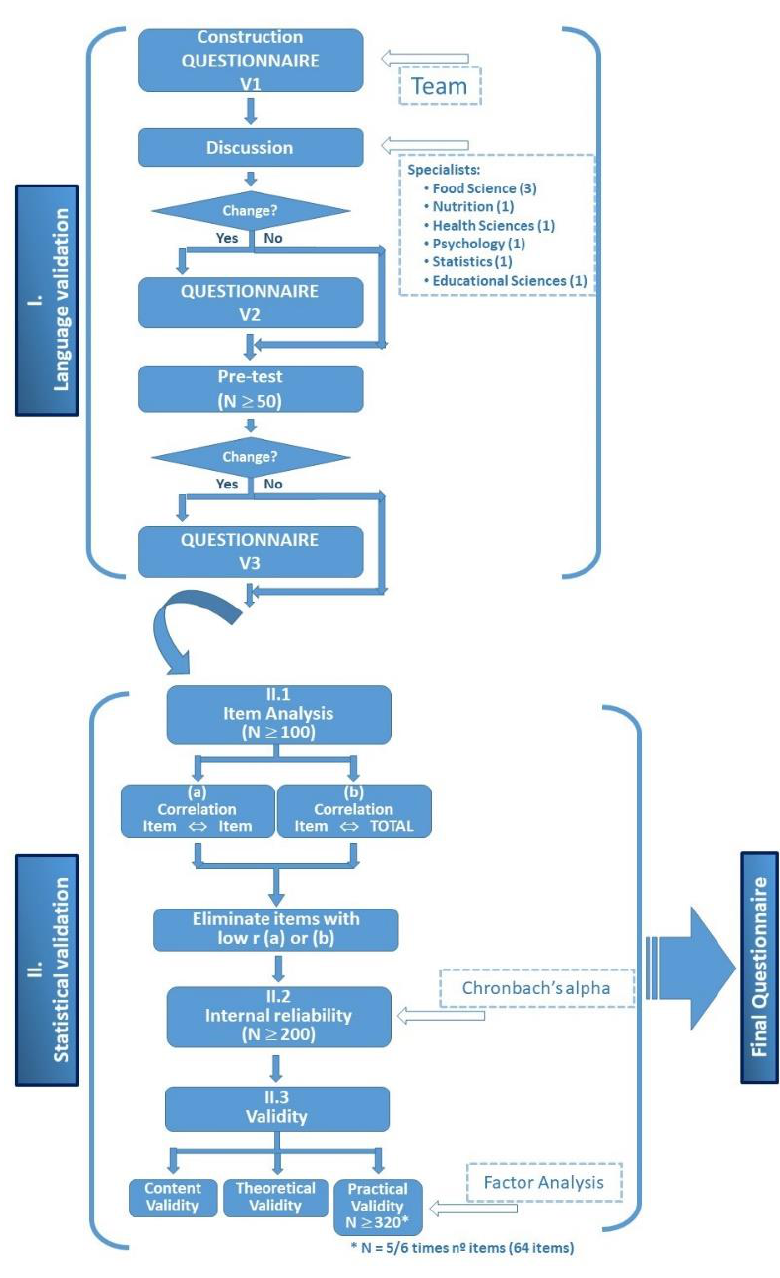
Figure 1. Validation algorithm.